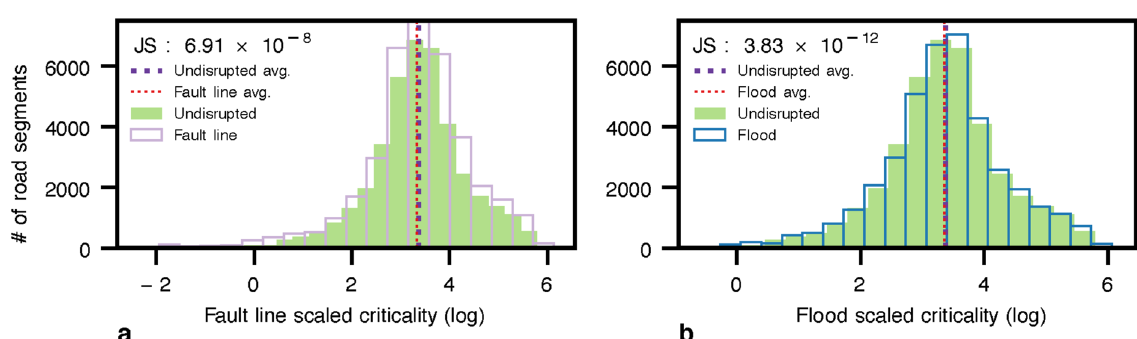
Figure 7. Criticality distribution for Lima city in log scale. Where ( a ) is the baseline and fault line scenario with a buffer of 500 m with a return period of 50 and 100 years, and ( b ) is the baseline and flood scenario of flood planning hazard map at historical return period. (a) show a slight change in the distribution. The Jensen- 8 12 Shannon divergences are 6.91 × 10 − and 3.83 × 10 − for (a) and (b),